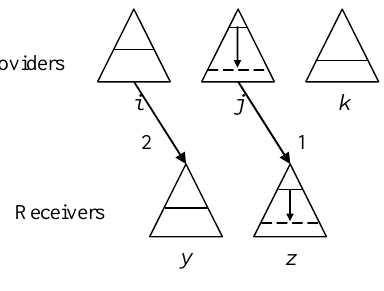
Fig. 2. Scheme of periodic review